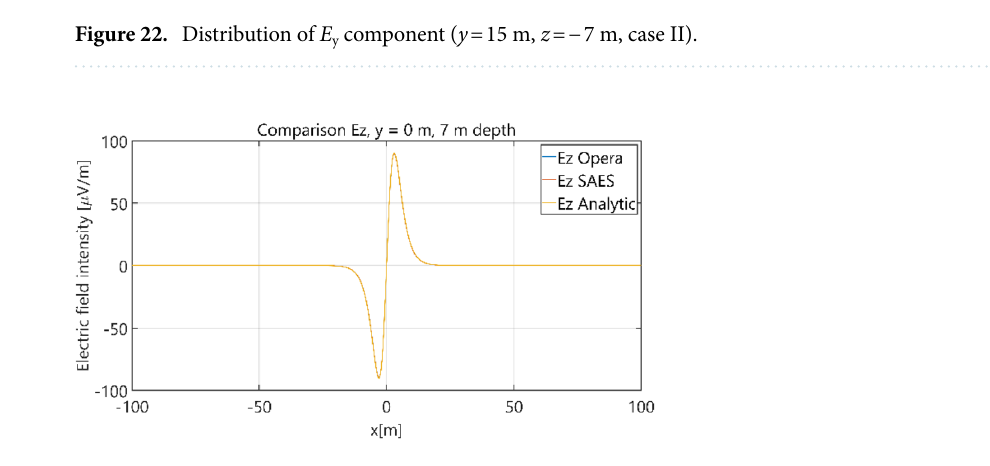
Figure 23. Distribution of E z component ( y = 0 m, z = − 7 m, case II).